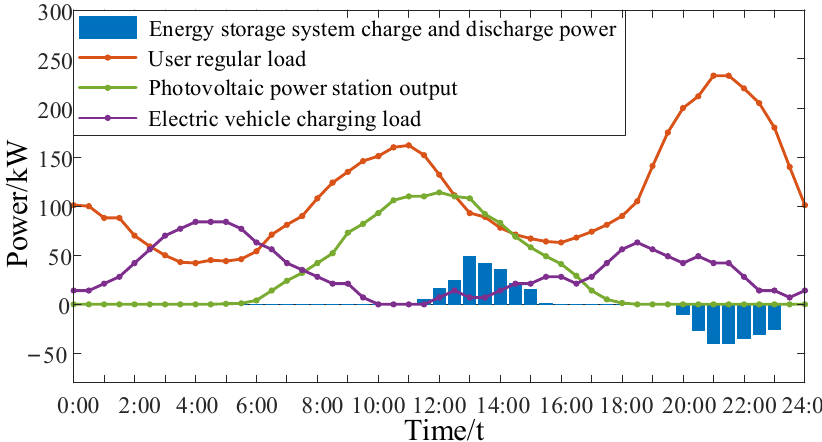
Figure 7. B-phase conventional load, photovoltaic generator output, battery output, and optimized electric vehicle charging load curve.